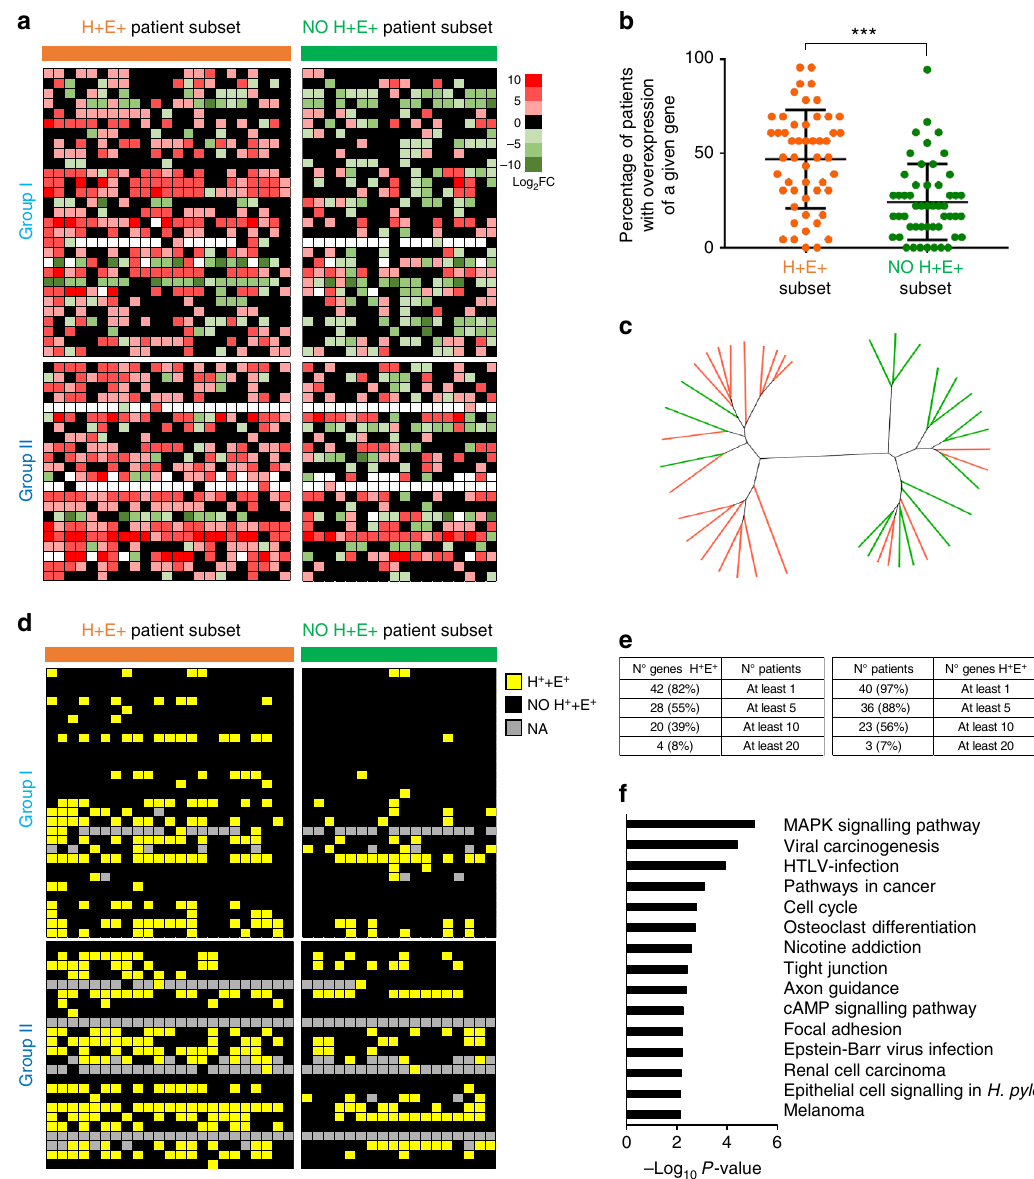
Fig. 6 The 55 genes identi fi ed in Alb-R26 Met tumours are also upregulated in the H + E + patient subset, and a large proportion of them is characterised by hypermethylated CGIs. a Heat-map reporting expression levels of genes found overexpressed and with hypermethylated CGIs in Alb-R26 Met tumours versus control livers (rows; subdivided in Group I and II and organised according to the relative position to the ATG) in individual HCC patients (columns; organised as in Fig. 5a). Red: upregulated genes; green: downregulated genes. Black: not differentially expressed. White: data not available. The scale is shown on the right (expressed as Log 2 FC). The H + E + patient subset is highlighted in orange (left), whereas all other patients in green (right). b In the graph, each dot corresponds to a given gene (the total 51 genes are reported). Their position corresponds to the percentage of patients in which the gene is overexpressed. In orange (left), for the H + E + patient subset. In green (right), for all other patients. c Unrooted distance tree of HCC patients based on the 51 genes identi fi ed in the Alb-R26 Met tumours. In orange: H + E + patient subset. In green: all other patients. d Heat-map highlighting with a yellow square genes overexpressed and with hypermethylated CGI in the corresponding HCC patient. The heat-map is organised as in panel A. Black square: genes not simultaneously overexpressed and with hypermethylated CGI in the corresponding HCC patient. Grey: data not available. e Tables reporting the numbers with percentages of genes overexpressed and with hypermethylated CGI in at least 1, 5, 10 or 20 HCC patients (left), as well as numbers with percentages of patients with at least 1, 5, 10 or 20 genes overexpressed and with hypermethylated CGI out of the 55 genes identi fi ed in the Alb-R26 Met model (right). f Histogram reporting the KEGG pathway enrichment analysis for the 55 genes identi fi ed in Alb-R26 Met tumours, ordered according to the − Log 10 P -value. Signi fi cance is indicated on the top. *** P <